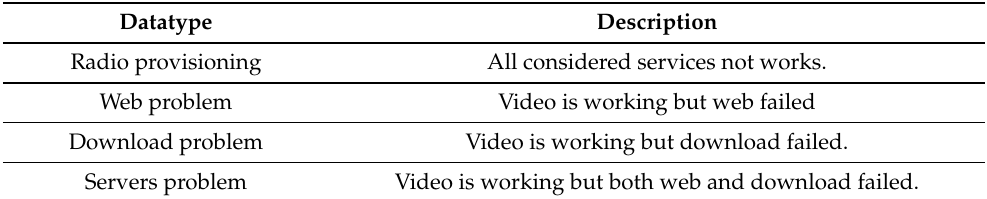
Table 7. Service problem events list.